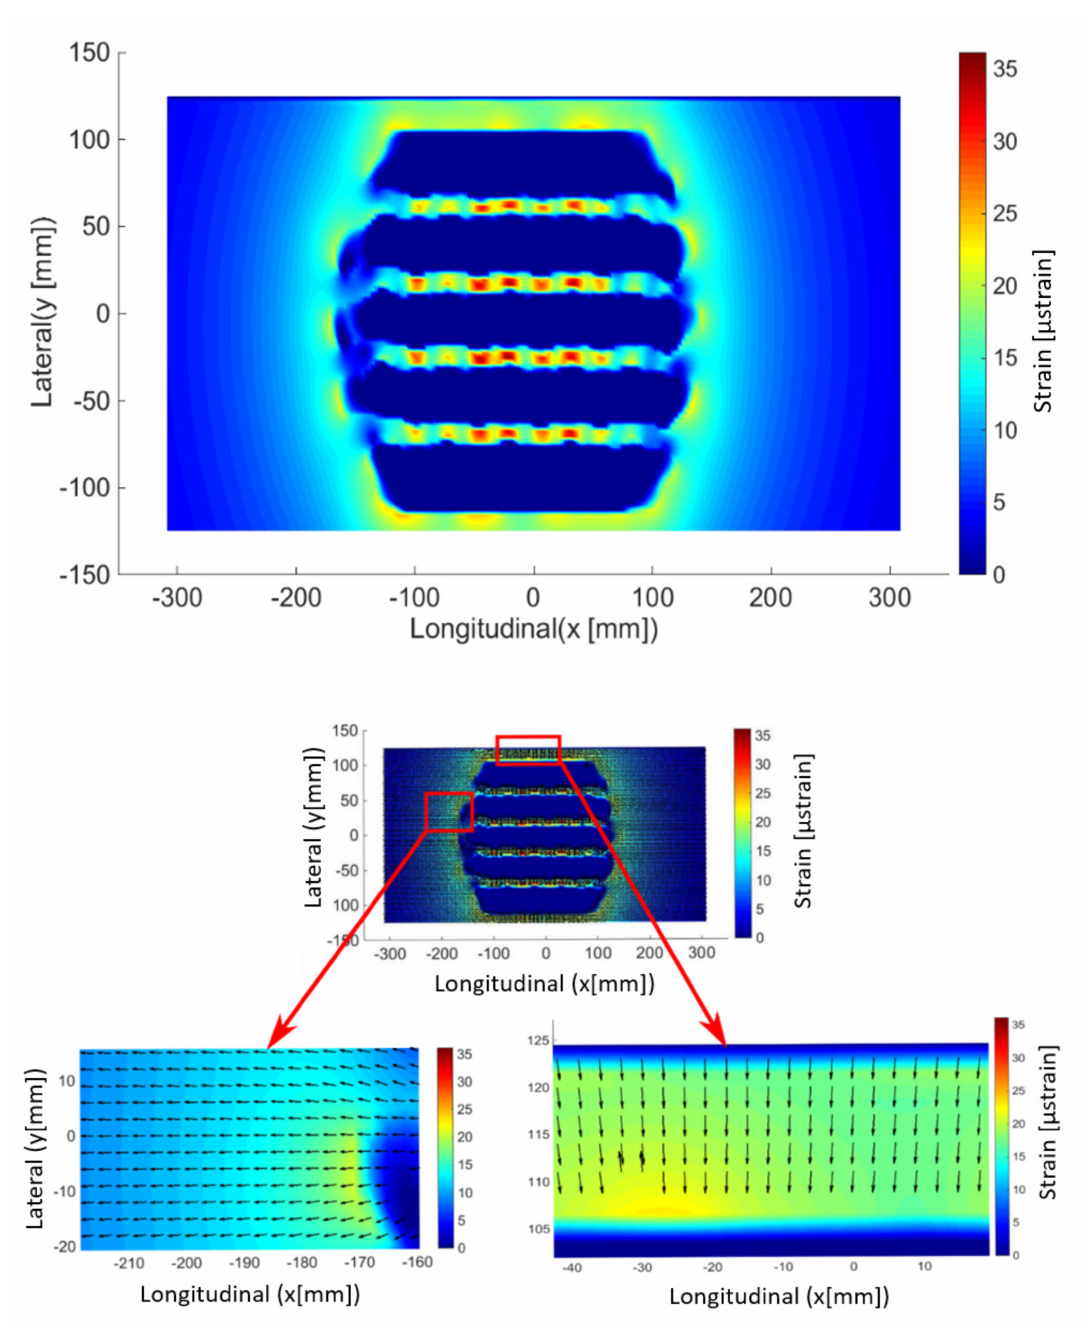
Figure 8. Maximum principal strain (by extension) at the pavement surface ( up ) and corresponding principal direction ( bottom ) for free